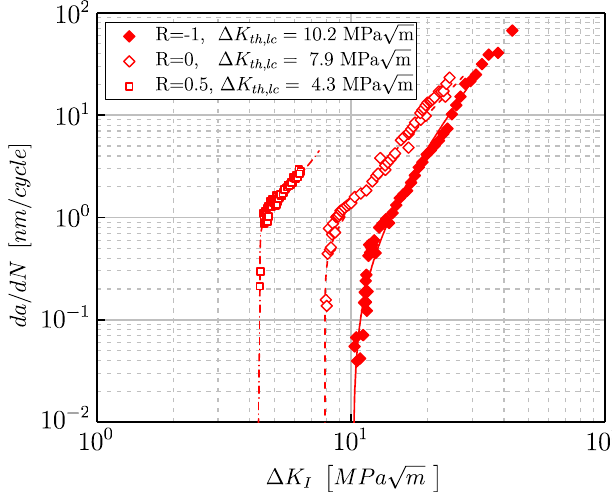
Figure 19. Resulting cyclic crack propagation data under R = − 1, R = 0 and R =